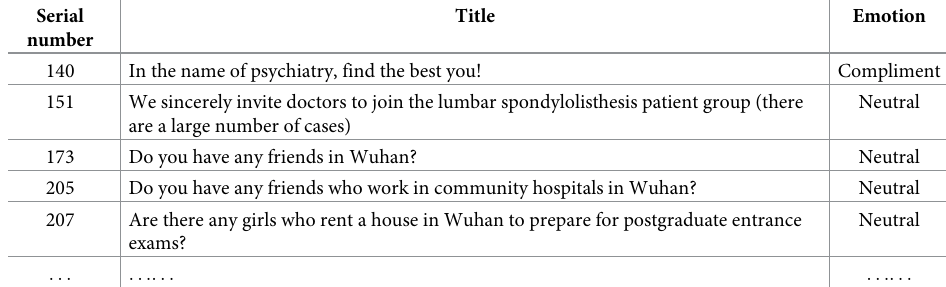
Table 8. Cases of social user participation in the "Lilac Forum" during the pandemic.